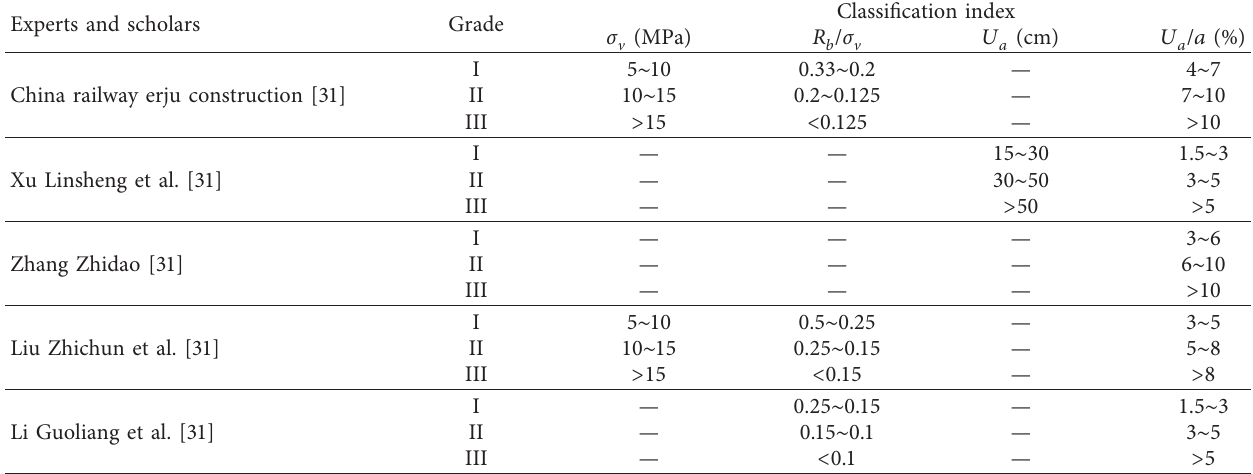
Table 1: Representative classification standards for large deformation of soft rocks in China.